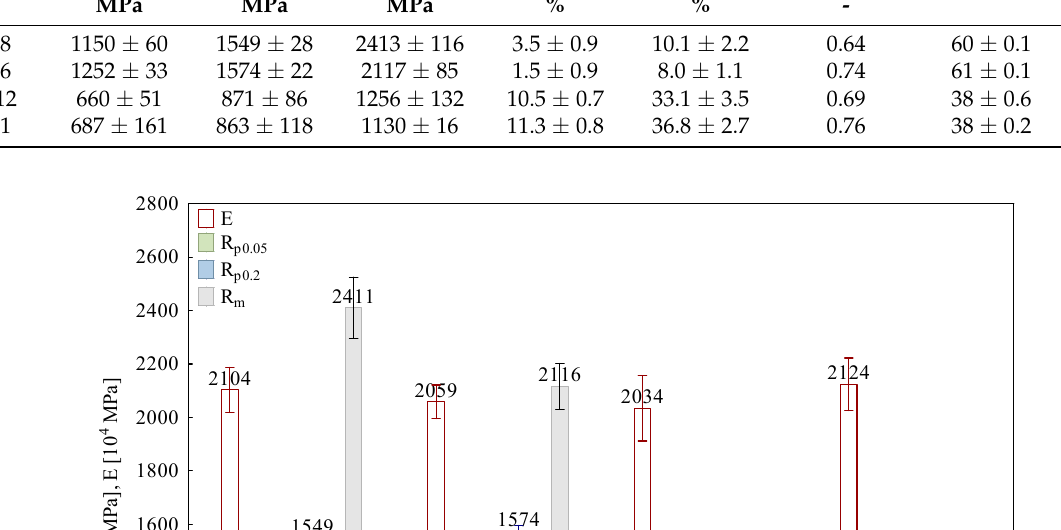
Table 2. Selected mechanical properties of Hardox Extreme steel: D—state of delivery, N—normalized state, L—longitudinal orientation, T—transverse orientation. Sample